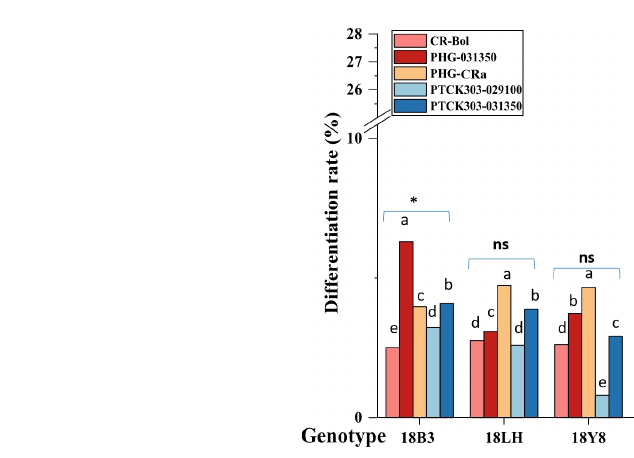
FIGURE 4 The differentiation rate of 5 vectors detected in different broccoli genotypes. Statistical signi fi cance levels are as follows: ns indicates no signi fi cant difference at a level of 0.05, * indicates a signi fi cant difference at p<0.05; and ** indicates a signi fi cant difference at p<0.01. Different lowercase letters indicate signi fi cant differences at